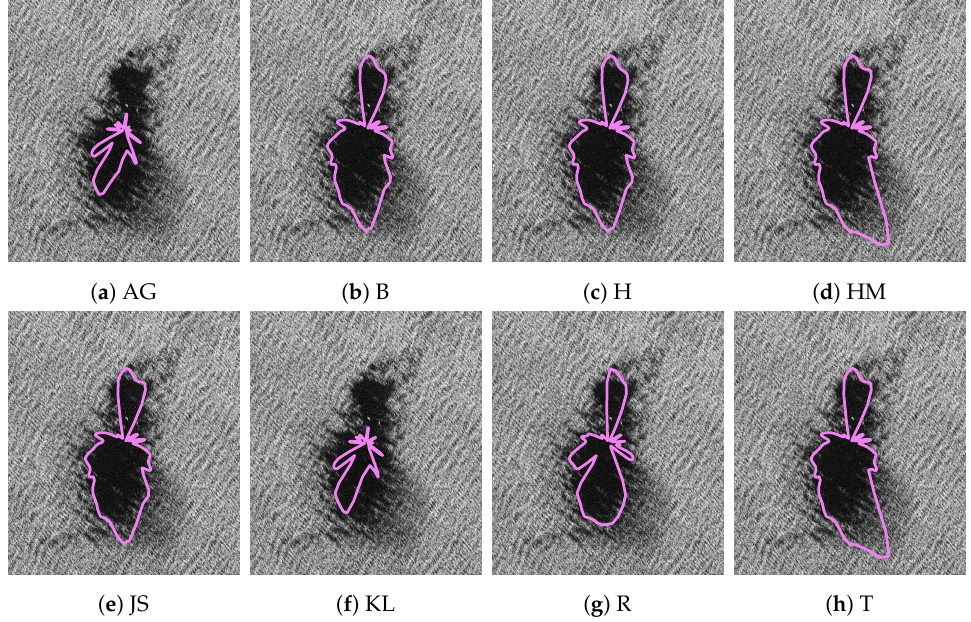
Figure 12. B-spline curves from the inlier points obtained by the proposed algorithm applied to the image of Figure 4, for each stochastic distance and n r =